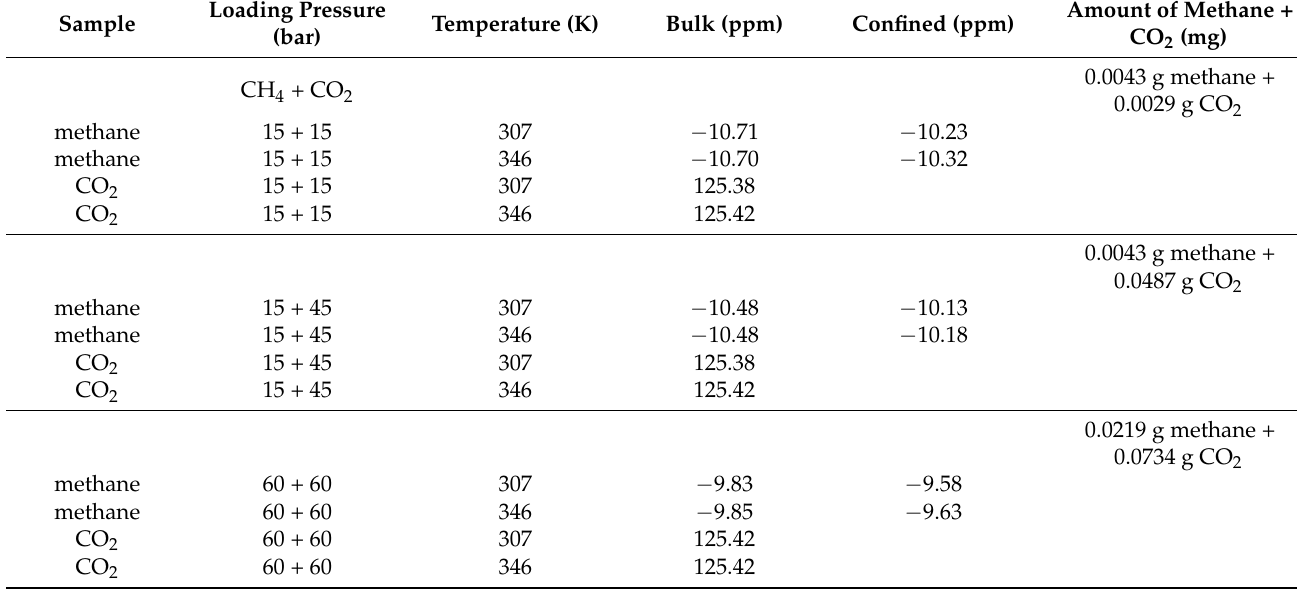
Table 3. Sample conditions, compositions, and measured 13 C NMR isotropic chemical shift values of methane in mixtures with CO 2 interacted with 2.5 nm silica with 0.0478 mg. Loading pressures of methane were 15 or 60 bar, while loading pressures of CO 2 were 15, 45, and 60